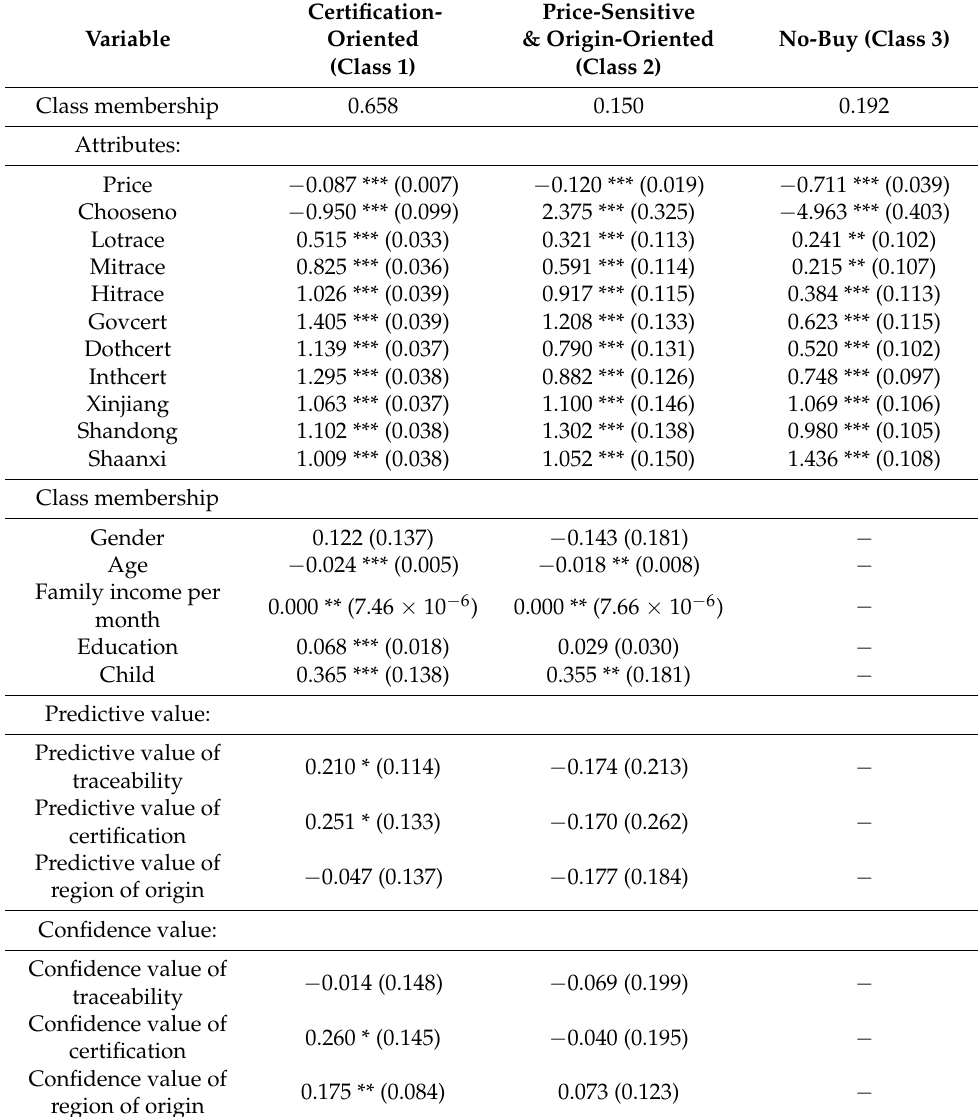
Table 5. LC model with perceived value and confidence value as class